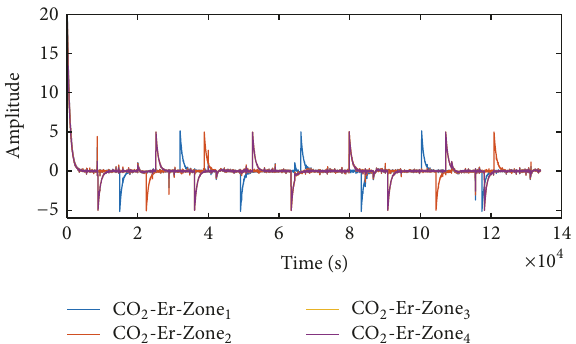
Figure 19: Controller action (steady state error) of CO 2 level responses for each zone CO 2 -Er-Zones.